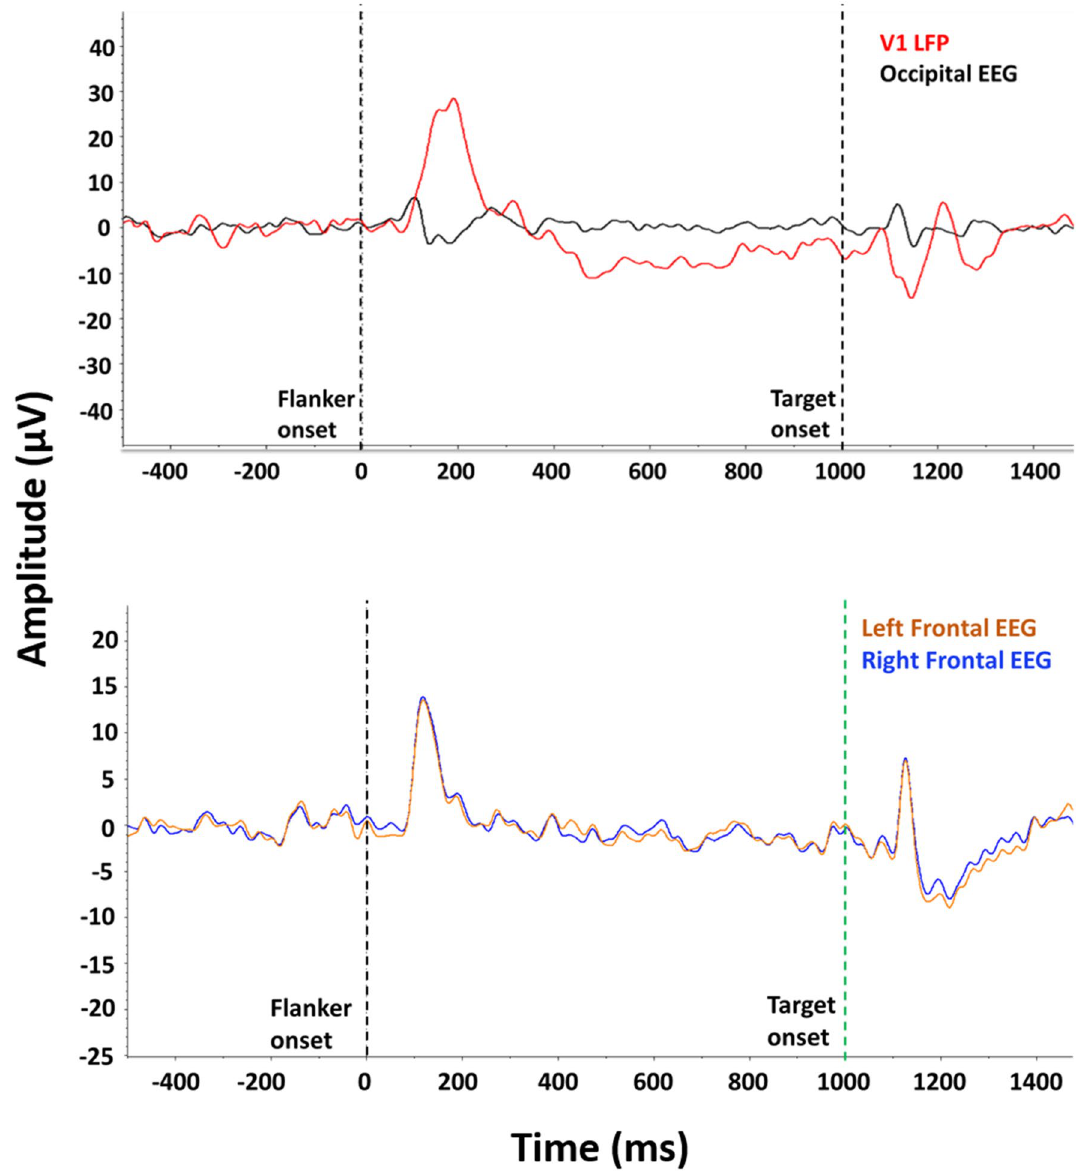
Figure 4. Flanker-locked VEPs for electrodes located in visual and frontal areas. Top panel: VEP grand average of all trials for the occipital EEG electrode (black tracing) and the V1 LFP electrode (red tracing). Bottom panel: VEP grand average of all trials for the left (orange tracing) and right (blue tracing) EEG electrodes. First vertical dashed line (time zero) corresponds to the flanker stimulus presentation and second vertical dashed line (at 1000 ms) represents the target stimulus onset. V1 LFP wire, n = 8; occipital and frontal screws n = after target stimulus presentation) was observed in the occipital EEG channel, which was highly similar to the positive peak observed after the flanker stimulus. As shown in the bottom panel of Fig. 4, the left (orange trac- ing) and right (blue tracing) frontal EEG electrodes displayed a positive peak 100 ms after the flanker stimulus presentation was observed in both channels, another positive peak following approximately 1100 ms, and, as well, a negative amplitude deflection around 1200 ms, which corresponds to 100 ms and 200 ms after the target presentation, respectively. Figure 5 presents findings during purple flowers (purple tracing) and green leaf (green tracing) trial types from the V1 LFP (top panel), occipital electrode (middle panel), and average individual-subject amplitudes for V1 LFP (bottom-left panel) and occipital (bottom-right panel) electrodes. Taken together, no significant differ- ences were observed in the VEP peak amplitudes (V1 LEP: 100–200 ms; occipital screw: 75–125 ms) between purple flowers and green leaf flanker trial types in the visual electrodes (V1 LFP: t [7] = 1.90, p = 0.10; d = 0.66; occipital screw: t [8] = 0.43, p = 0.68; d = 0.15). Figure 6 presents split-half internal reliability analysis of amplitude values in the 100–200 ms time window. As the figure highlights, high flanker-locked VEP reliability coefficients were observed for both visual electrode